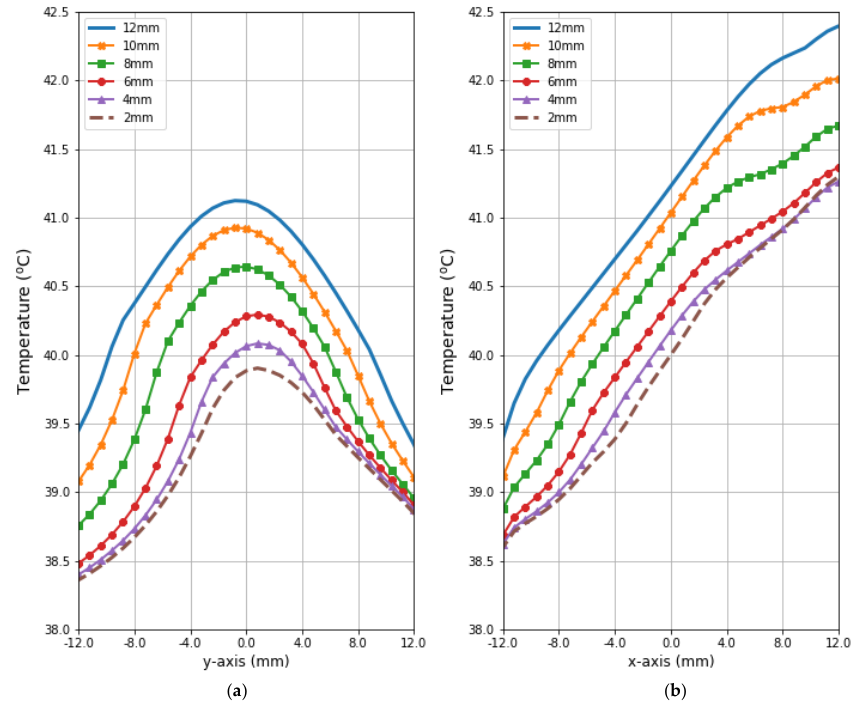
Figure 10. The heating curves running through the center of tumor of different sizes along ( a ) the y -axis perpendicular to the antenna matrix; ( b ) the x -axis in the direction of the eight-dipole antenna array after the optimization procedure.